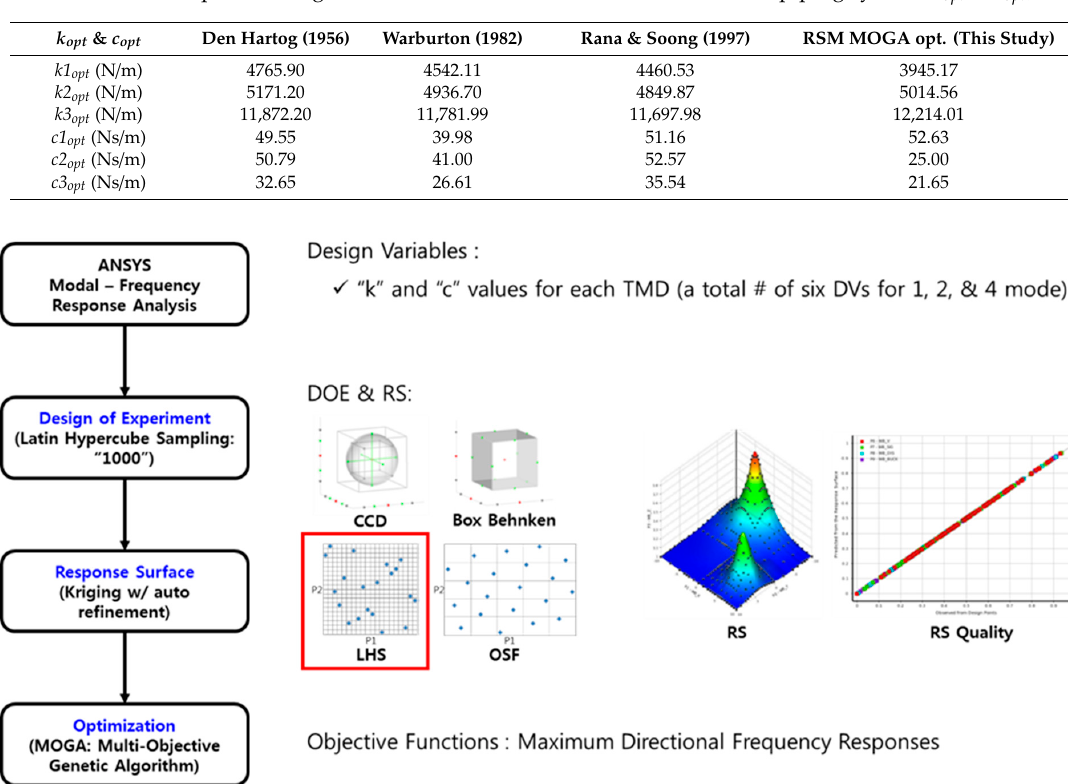
Table 4. TMD optimal design values for the NUREG / CR-1677 Benchmark piping system: k opt & c opt.